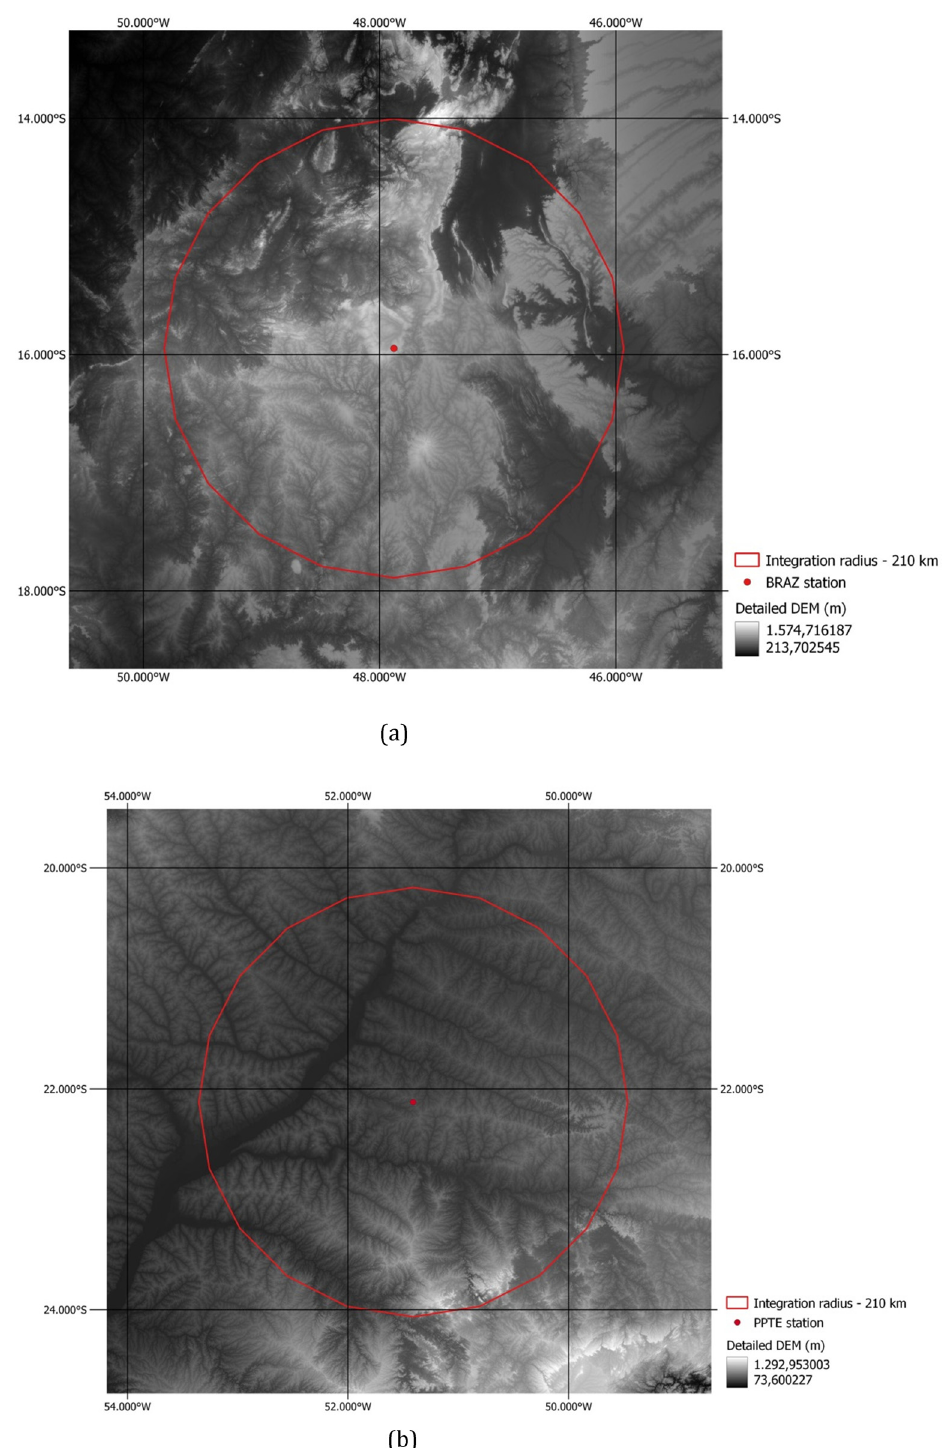
Figure 4: Study areas at ( a ) BRAZ and ( b ) PPTE IHRS future stations in Brazil. The red circles delimit the mass integration zones. The red dots are the